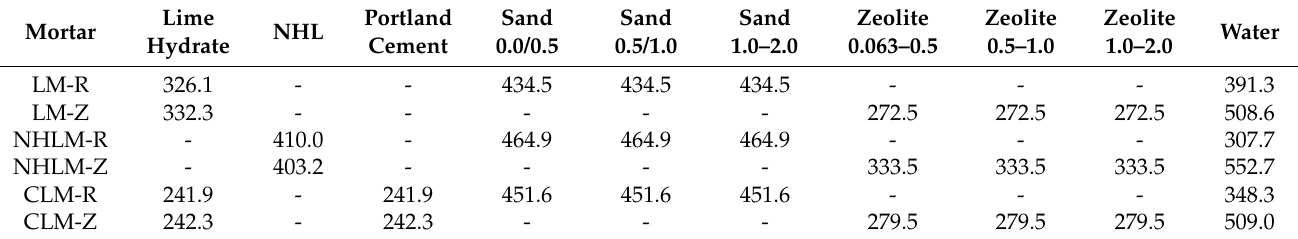
Table 1. Composition of the investigated rendering mortars, kg · m − 3